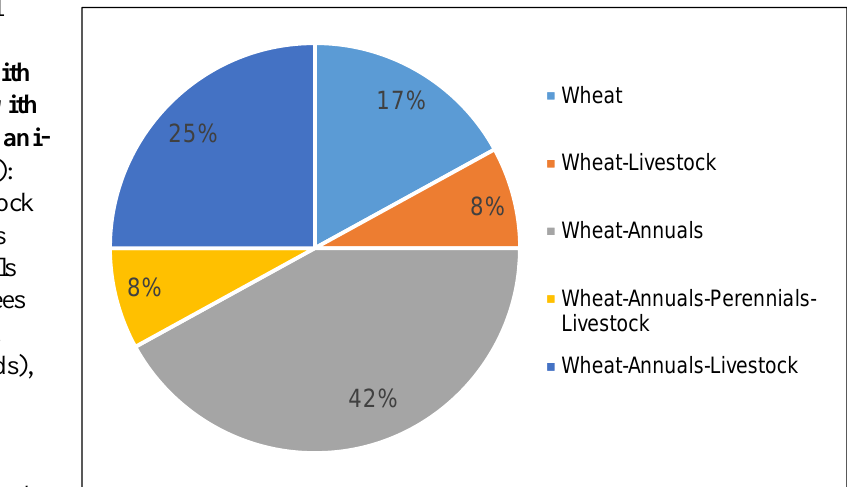
Figure 1. Wheat-based Production Systems in the West